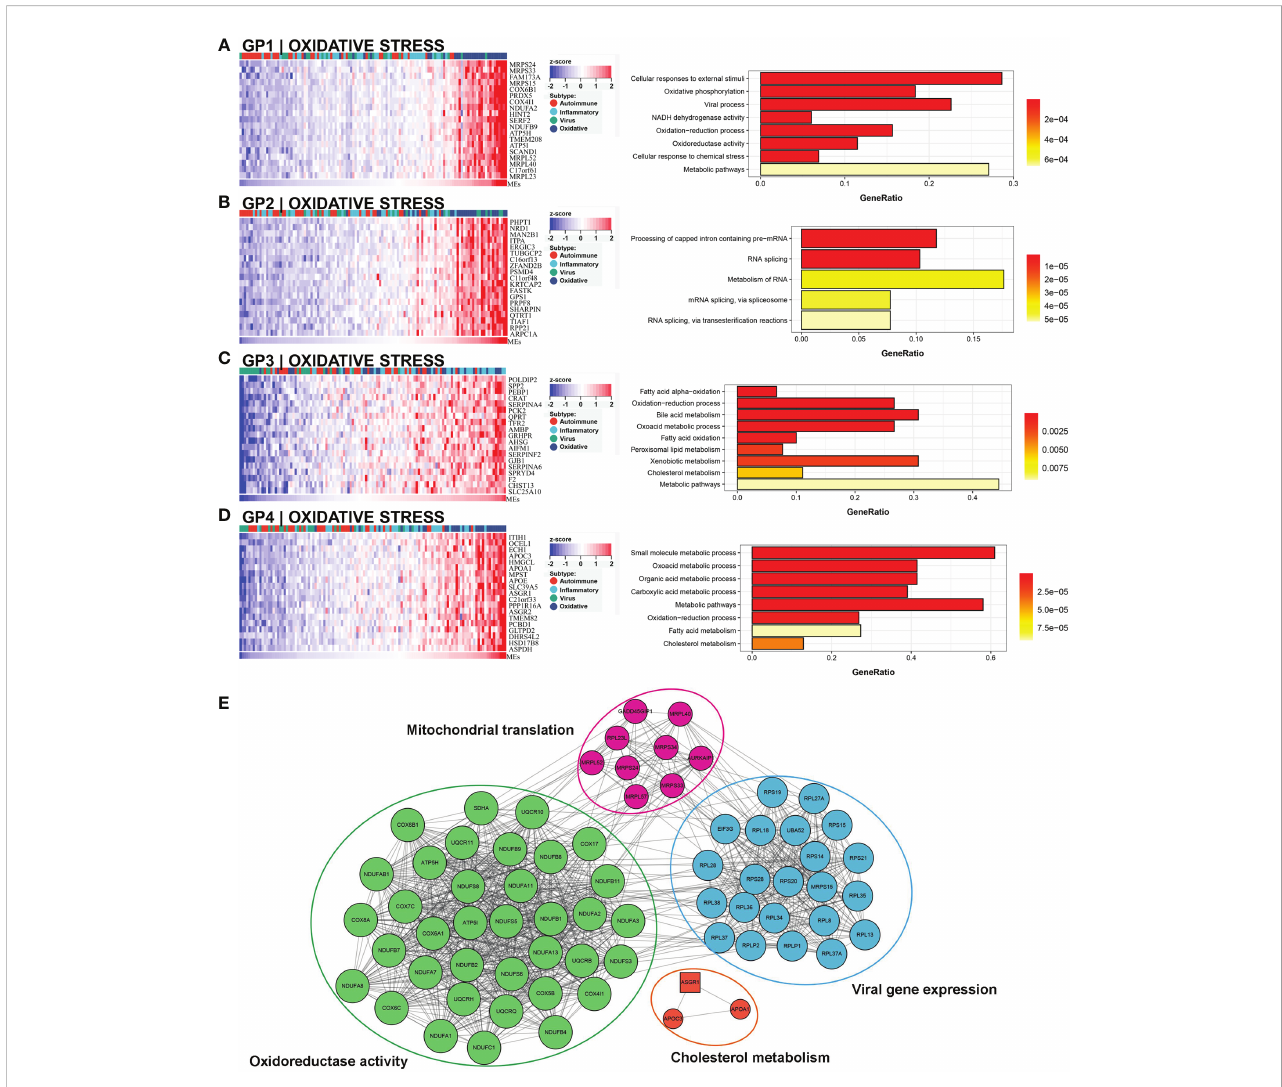
FIGURE 7 Core GP de fi ning the oxidative stress subtype. GP1 mainly revealed oxidative processes (A) . The main biological processes of GP2 were metabolism of RNA (B) . The biological processes of GP3 revealed oxidation and metabolism (C) . GP4 showed oxidative and metabolic processes (D) . The protein- protein interaction network revealed the protein interactions of representative genes in the oxidative subtype (E)